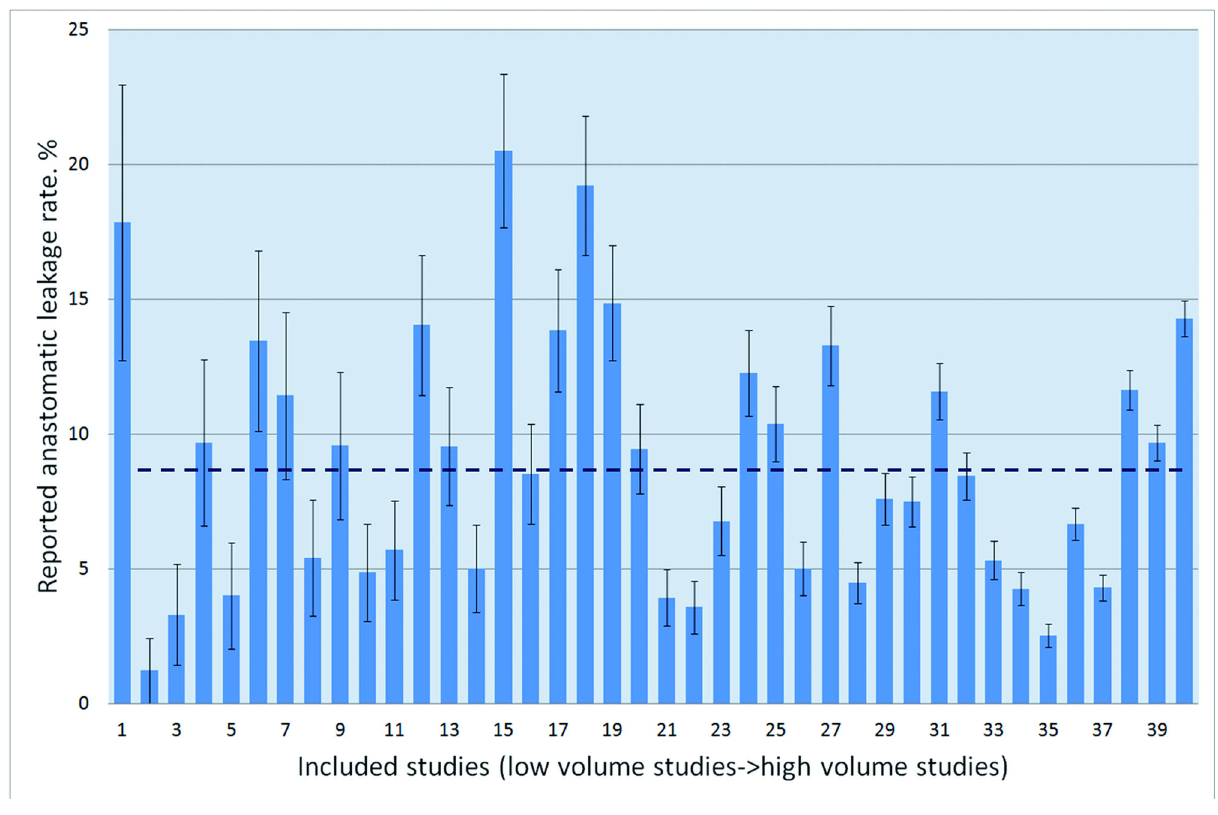
Figure 2. AL rates reported by the included studies on AR ranked by volume. doi: